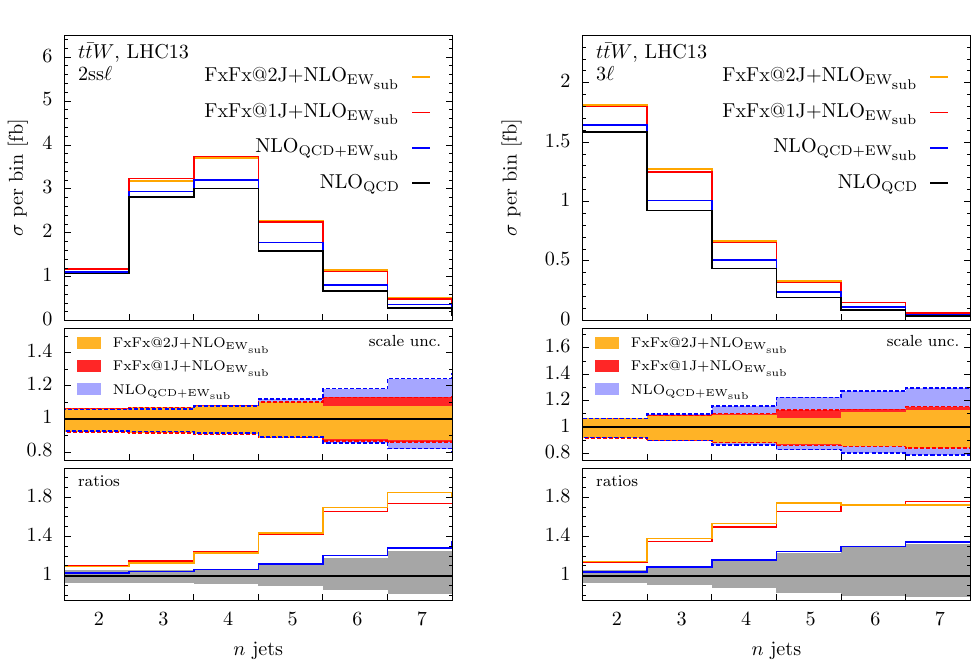
Figure 8 . Jet-multiplicity distributions for the 2 ss‘ and 3 ‘ multi-lepton